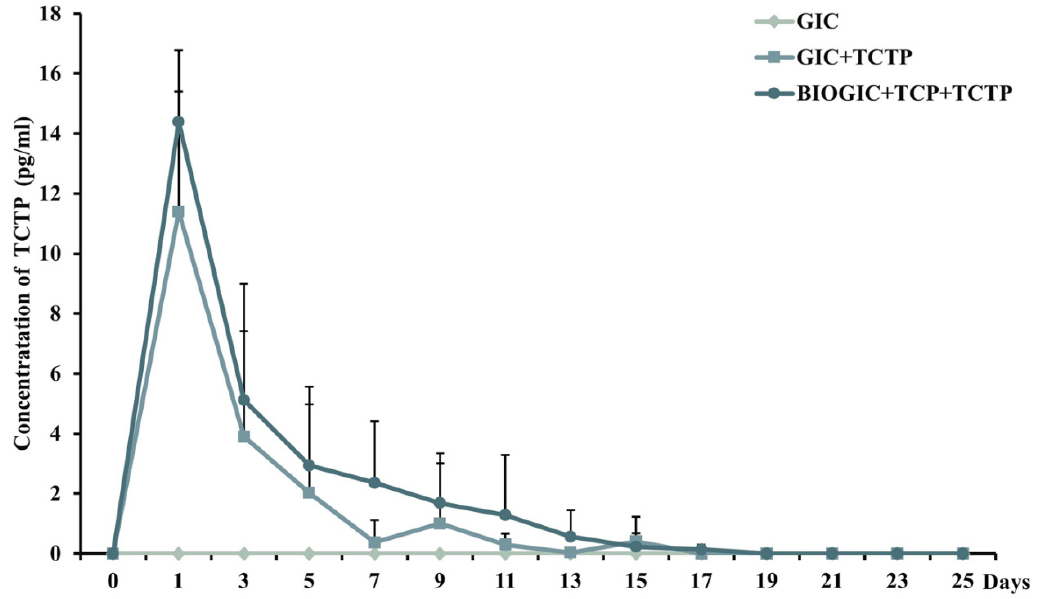
Figure 6. ELISA assay determined concentration of TCTP. TCTP was released from GIC and BIOGIC with added TCTP on day 1 to day 25.